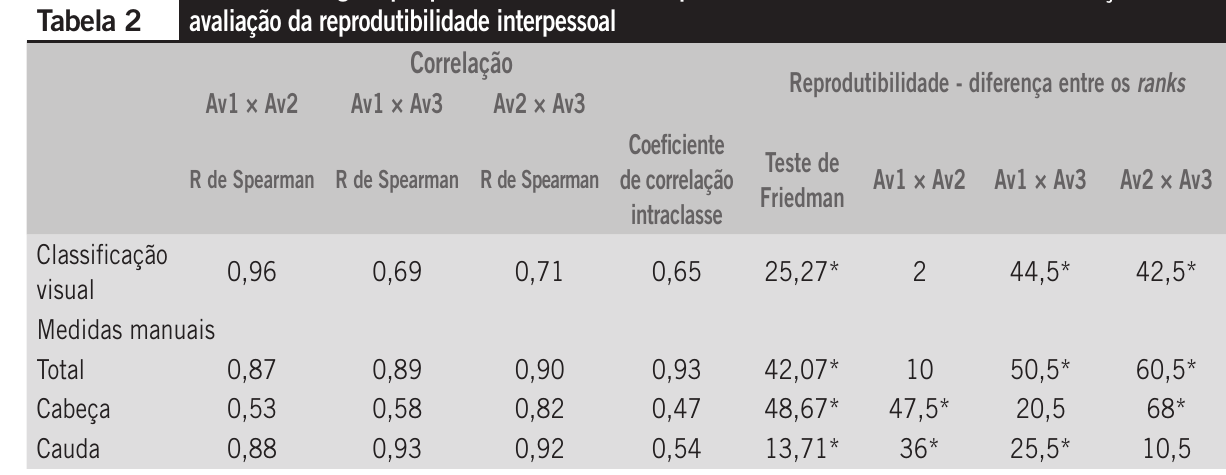
Análise de imagens pré-processadas de cometas por três avaliadores: estimativas de correlação